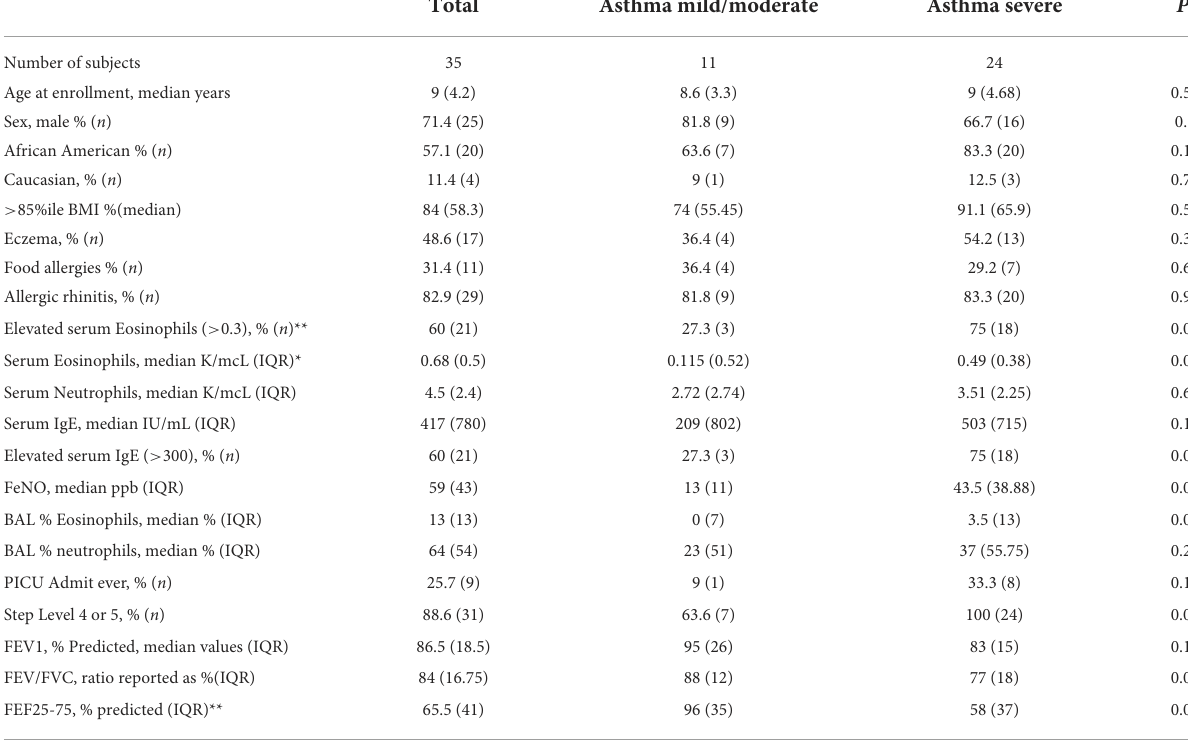
TABLE 1 Demographics and clinical characteristics according to asthma